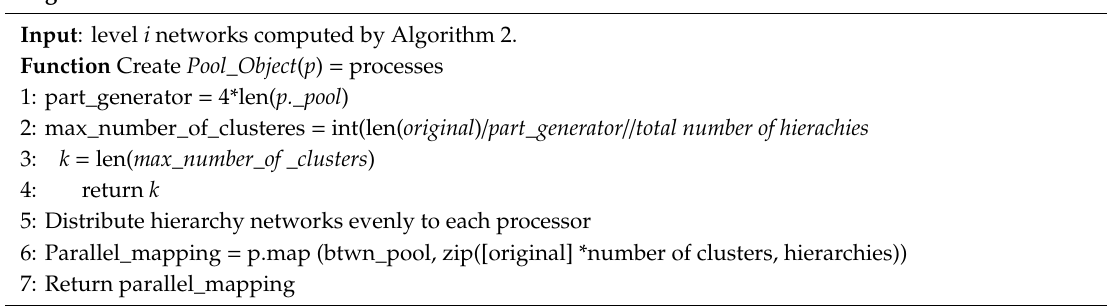
Algorithm 3. Parallelization of